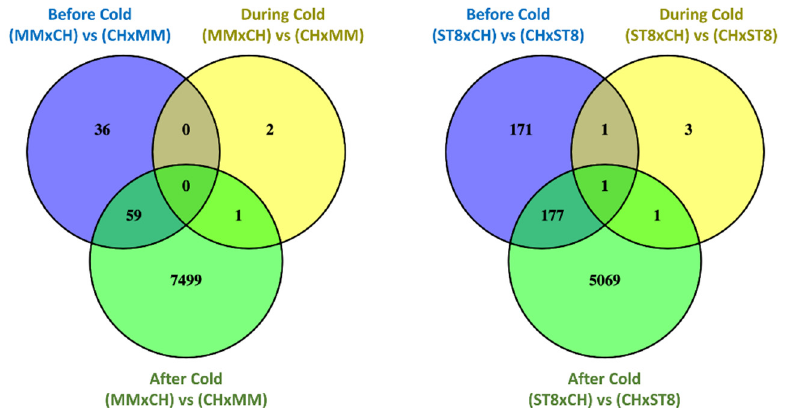
Figure 4. Venn diagrams comparing significantly ( FDR < 0.05) differentially expressed genes (DEGs) between reciprocal hybrids sets, MMxCH versus (vs) CHxMM and ST8xCH vs CHxST8, before cold treatment (Before Cold; blue), at hour 3 during cold treatment (During Cold; yellow), and 24 h after onset of cold treatment (After Cold; green). Plants were grown in a greenhouse at 28 °C for 10 days then plants were treated at 4 °C for 5.5 h at a light intensity of 270 µmol·s − 1 ·m − 2 .